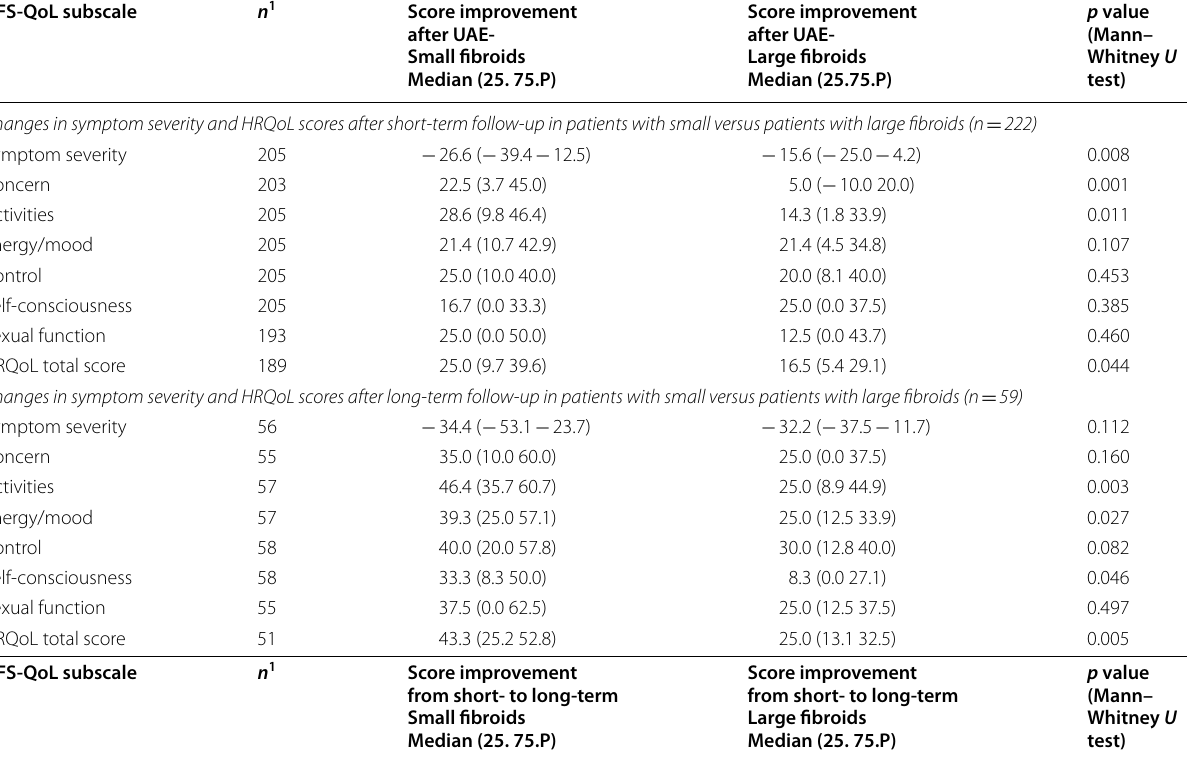
Table 4 Changes in symptom severity and HRQoL scores after UAE in patients with small versus patients with large fibroids